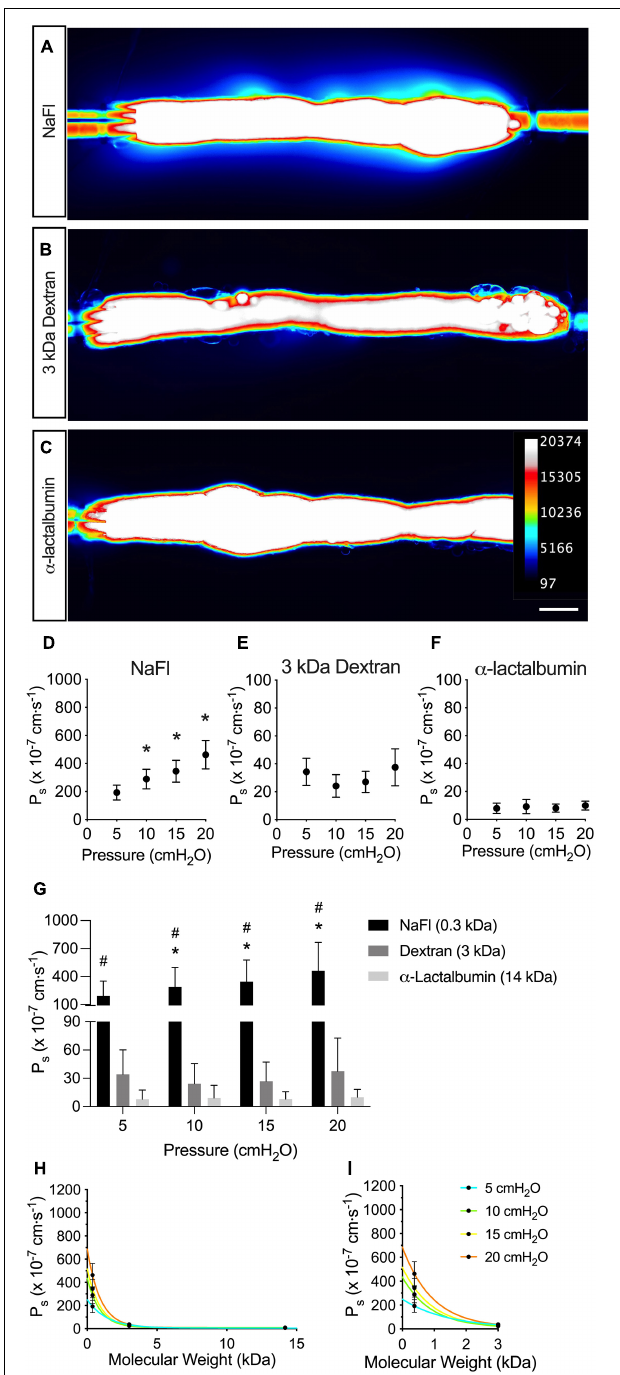
FIGURE 2 | Solute permeability is inversely related to solute size. Solute flux was measured to three different solutes across a range of physiologically relevant sizes and solute permeability (P s ) quantified. (A–C) Visualized leakage of each indicated solute from collecting lymphatic vessels. Fluorescence intensity of each solute was captured with a CMOS camera and the intensity converted to a heat map (see inset for scale). (D–F) P s to each indicated solute plotted against pressure to show mean values and convective flux (NaFl, n = 9; 3 kDa dextran and α -lactalbumin, n = 7). (G) A summary of the